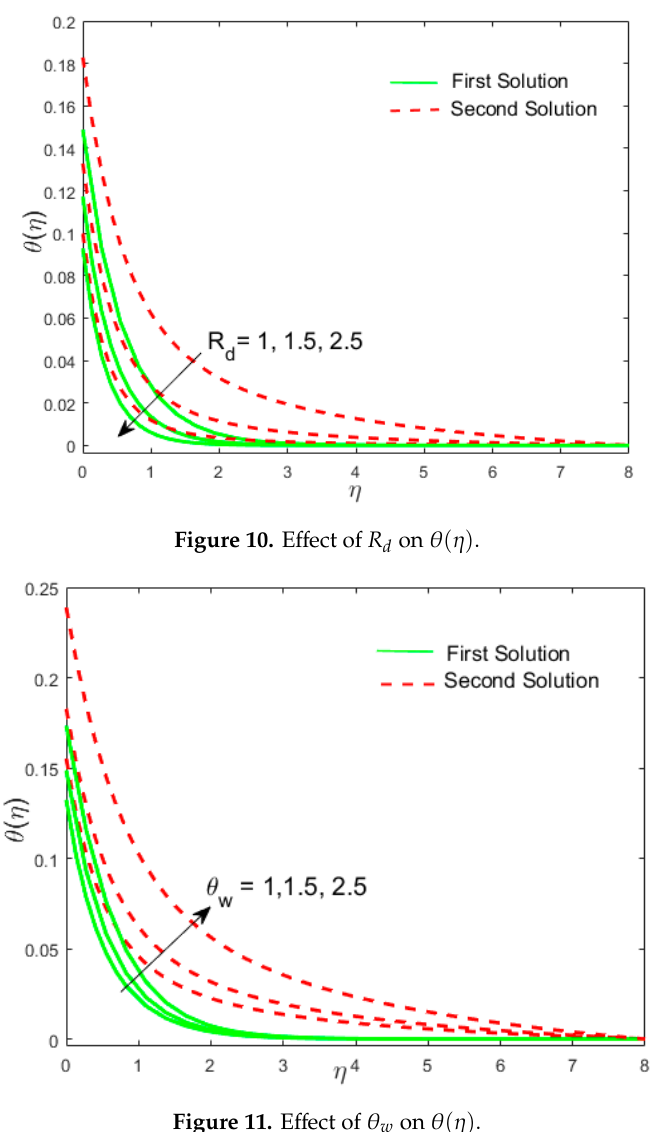
Figure 11. E ff ect of θ w on θ ( η ) Figure 11. Effect of Figure 11. Effect of